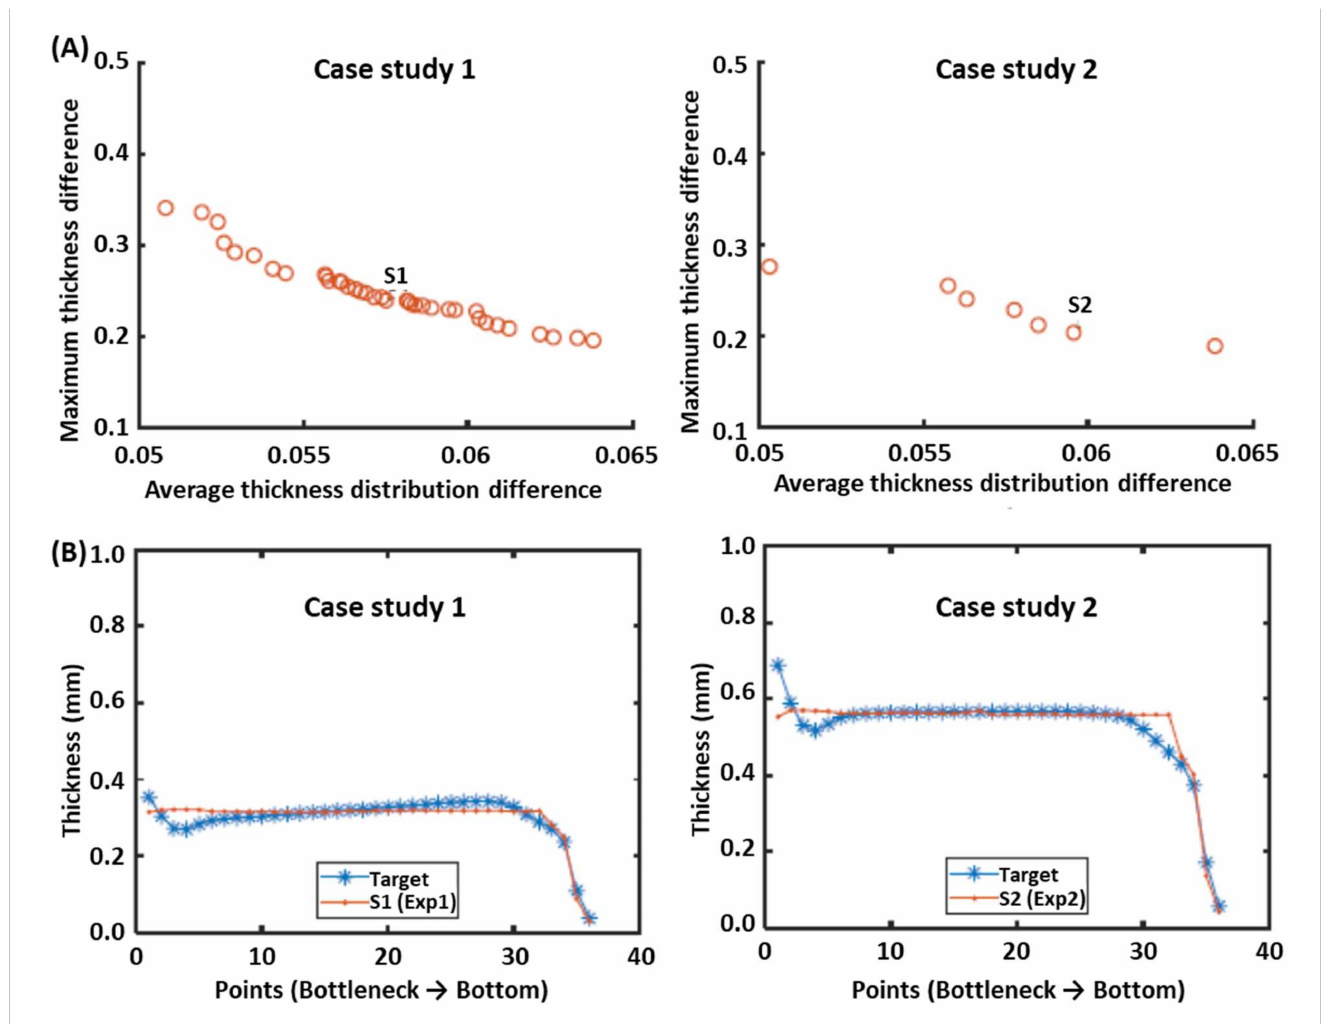
Figure 4. Multi-objective optimization of the preform to obtain the target bottle previously opti- mized for two case studies: ( A ) Pareto front, average thickness distribution difference between the obtained and the target bottles versus maximum thickness difference between obtained and target bottles; ( B ) comparison between the target bottle profile and the bottle profile obtained for optimized solutions S1 and S2 (adapted from